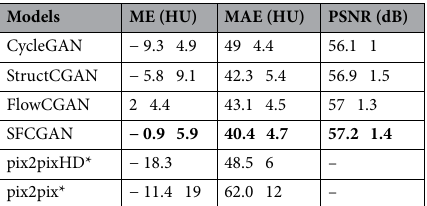
Table 2. The table shows the scores of different model averaged across test volumes inside the whole body contour. *Taken from Boni et al. 3 . Results from SFCGAN are in bold font.